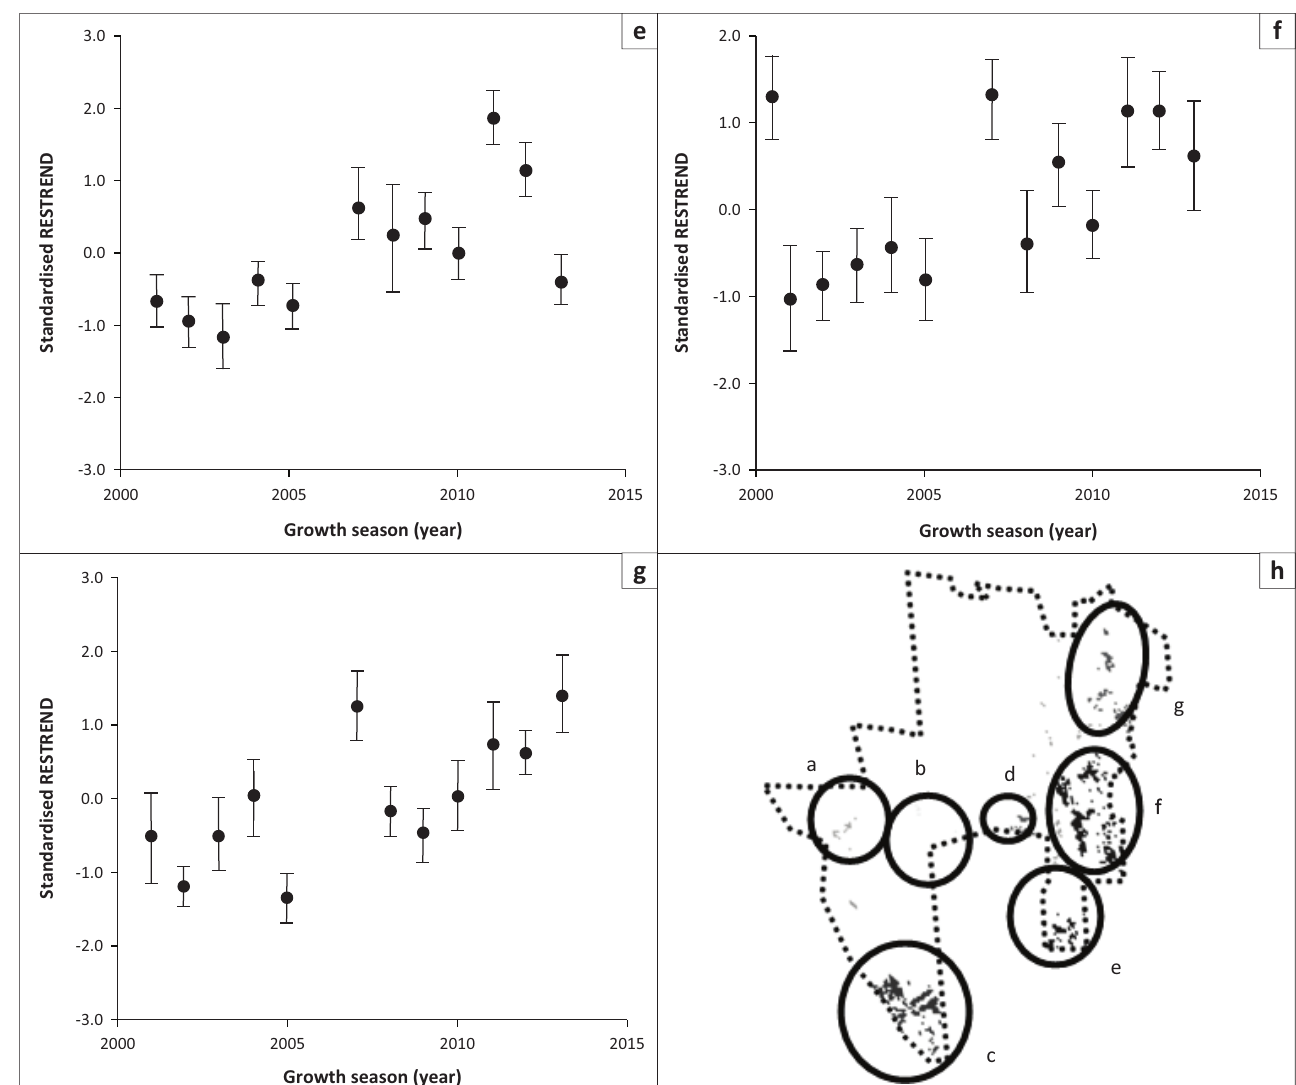
FIGURE 9 (Continues...): Examples of significant trends in standardised residual trend analysis values over time from several areas with significant decreasing trends (graphs a and b) or increasing trends (graphs c–g) in the Tswalu Kalahari Reserve; (h) The small map indicates the general area covered by each graph. Values are shown as mean (± standard deviation) for each